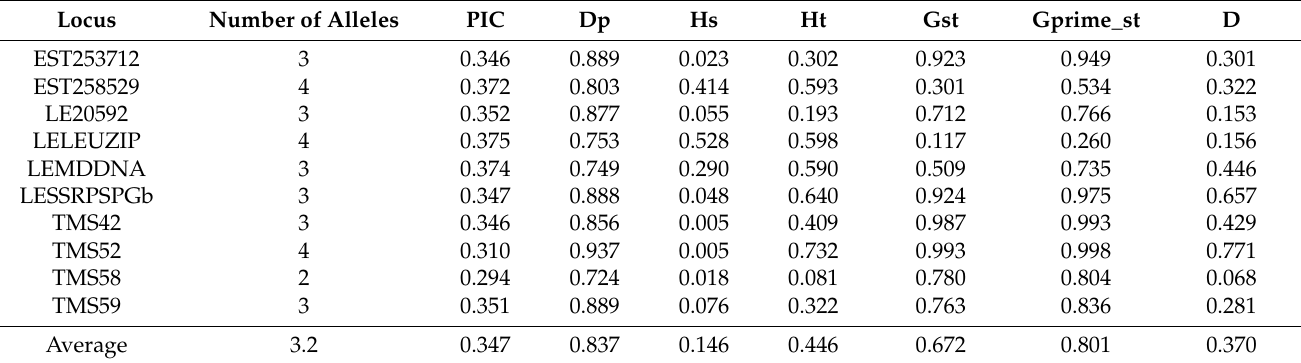
Table 3. Allele summary statistics and diversity indexes across the analyzed